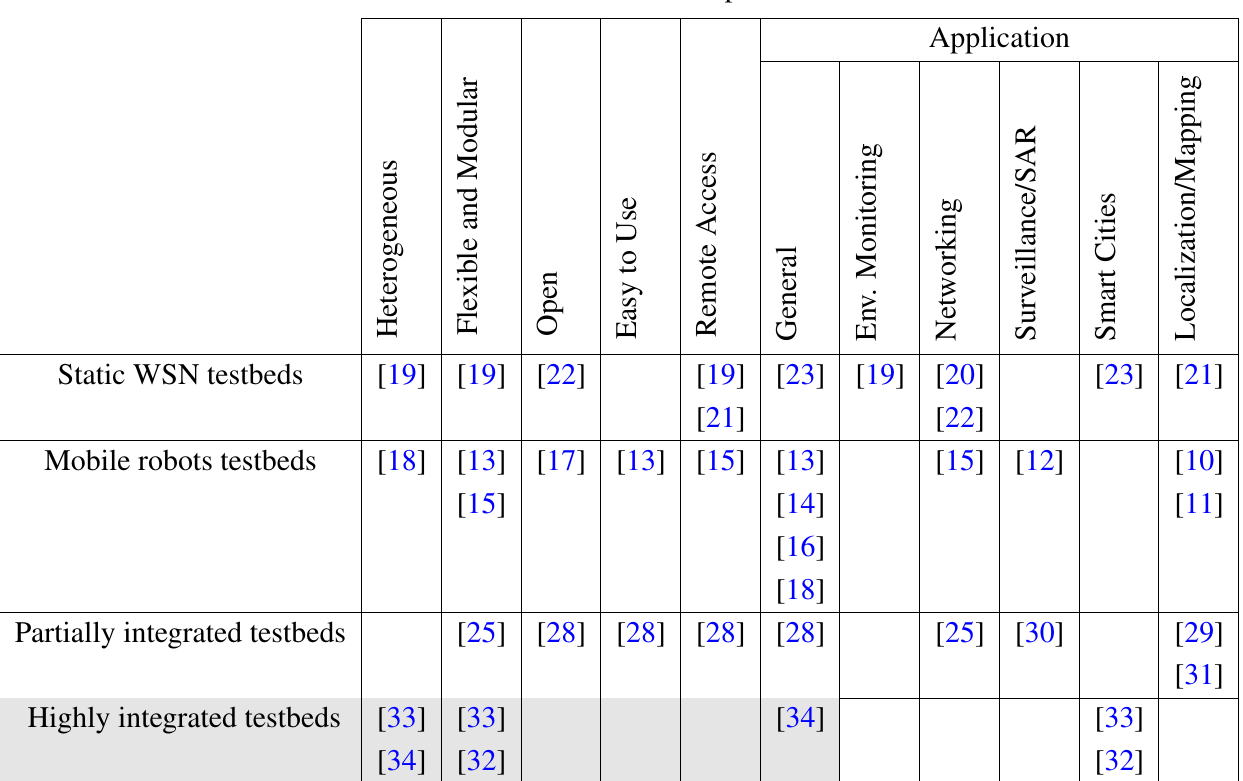
Table 1. Main features of the testbeds reported in the